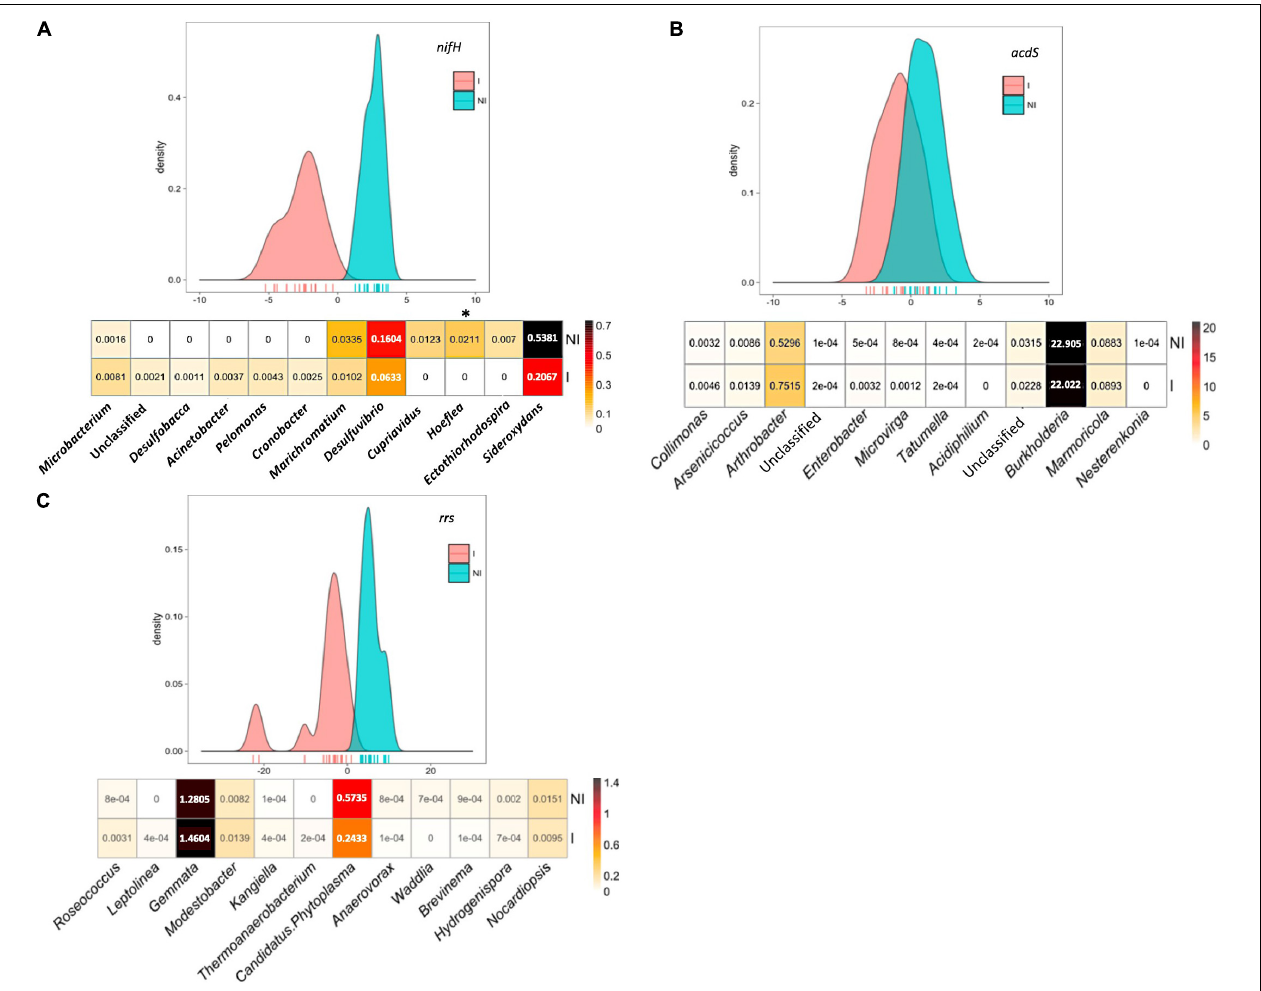
FIGURE 5 | Between-class analysis of the effect of seed inoculation with A. lipoferum CRT1 on the composition of (A) nifH and (B) acdS functional groups, as well as (C) the total bacterial community ( rrs ) over three sites. Analyses were done on pooled data of bacterial composition of maize rhizosphere of the three sites studied. NI and I correspond, respectively, to non-inoculated and inoculated conditions. For each bacterial group, the BCA graph is completed (below) by the distribution of the bacterial OTUs according to their contribution to treatment differentiation. BCA is statistically supported by a Monte Carlo test based on nifH ( p = 0.001) and rrs data ( p = 10 - 4 ), but not with acdS data ( p = 0.19), and the heatmap below indicates the relative proportions for the 12 bacterial genera most impacted by inoculation in maize rhizosphere. Six bacterial genera most commonly associated with inoculation are indicated at the left, as well as six bacterial genera most often associated with the non-inoculated control (right). Statistical differences between inoculated and non-inoculated treatments are indicated by stars ( ∗ ) (Wilcoxon test, p < 0.05). Heatmap unit is a percentage of the average relative proportion of